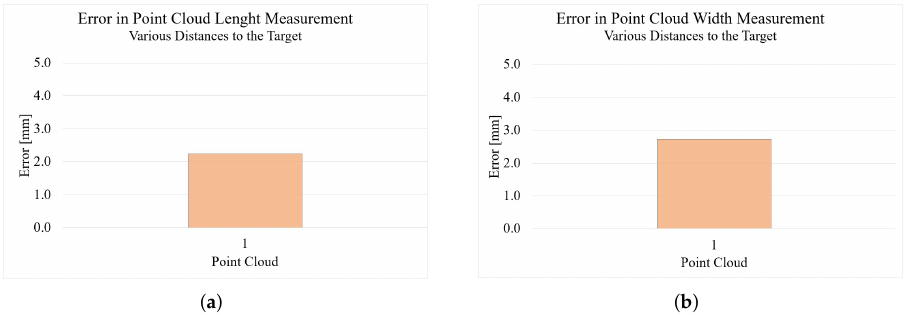
Figure 11. Results of the foot measurement with Agisoft Metashape: ( a ) result length; ( b ) result width.